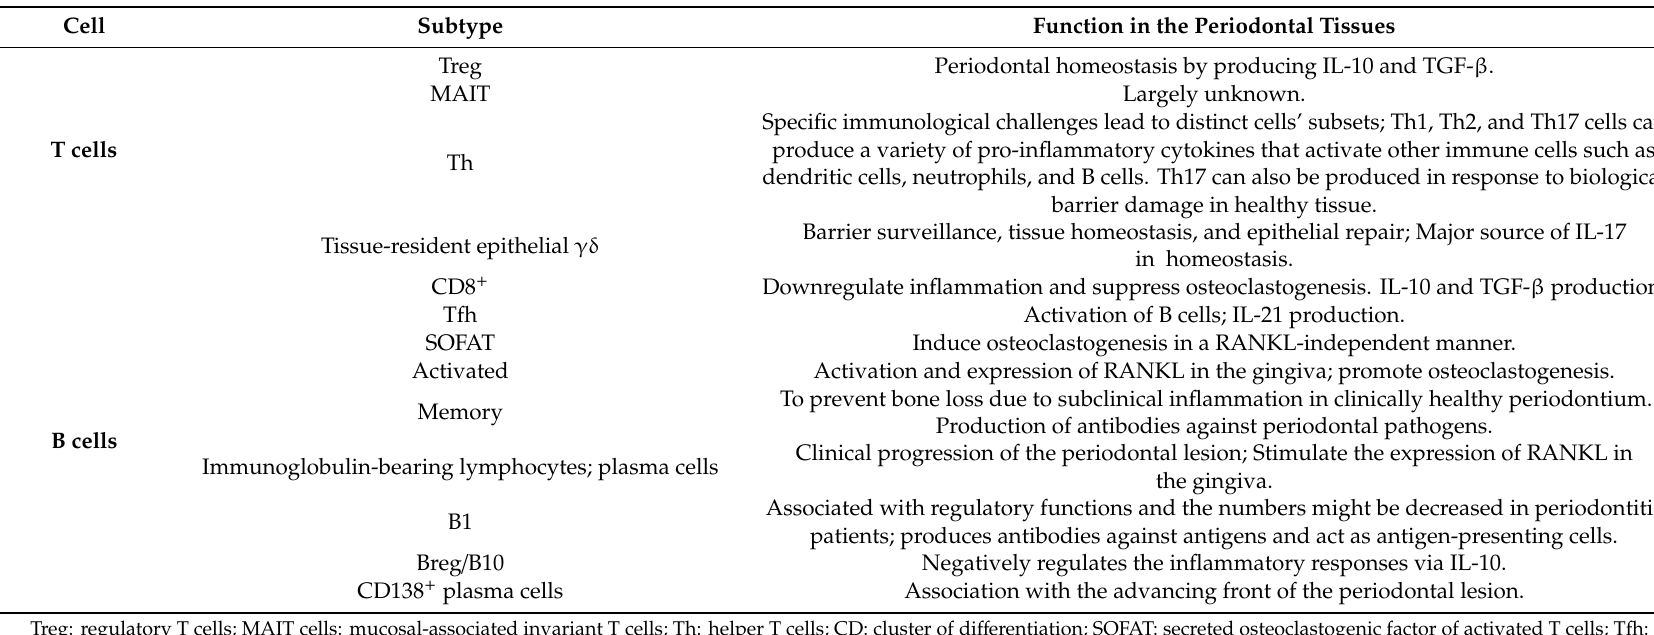
Table 1. A summary of the main functions of mentioned T and B cells in periodontal health and